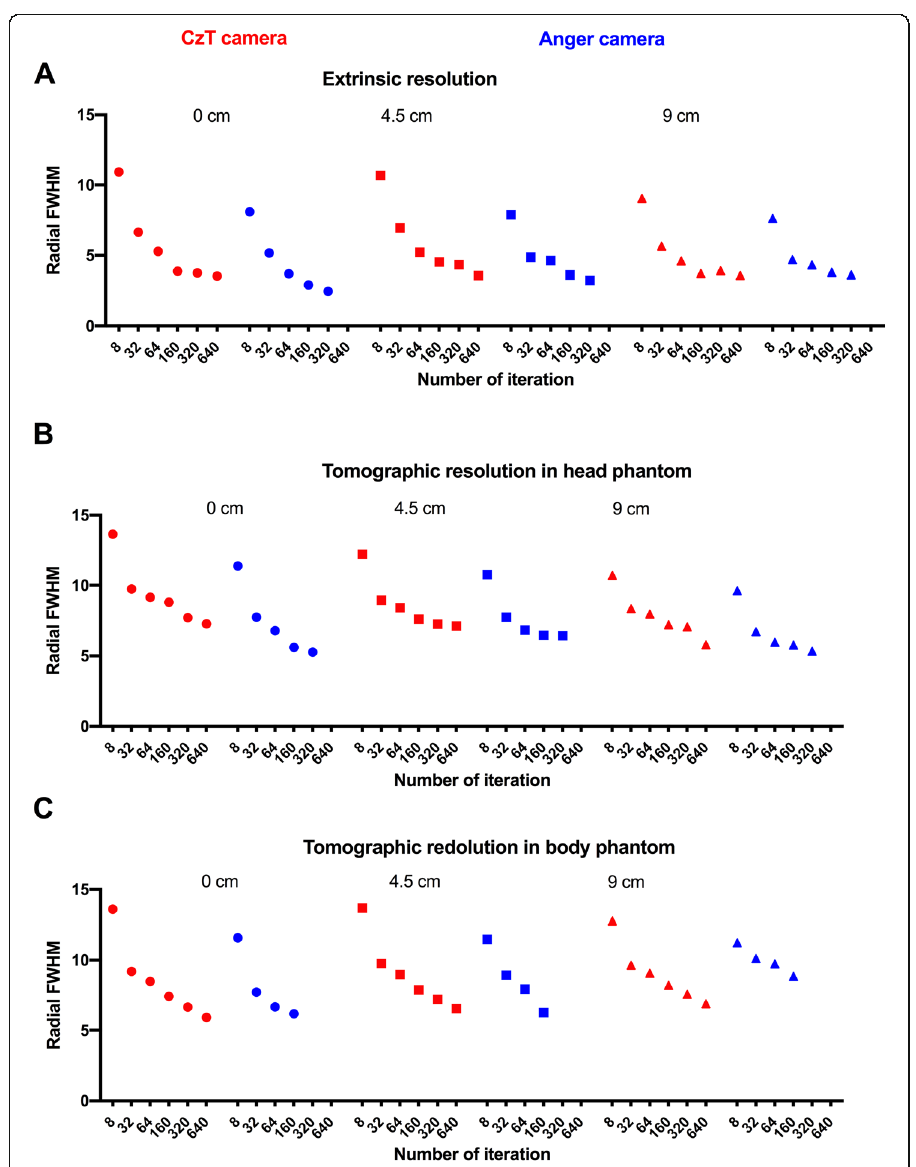
Fig. 2 Estimated radial spatial resolution of Anger and CzT cameras as a function of the distance to the centre of the field of view (ranging from 0 to 9 cm) measured in air ( a ) in a head phantom (from IEC Standard 61675-2) ( b ) and in a body phantom (from IEC Standard 61675-1) ( c